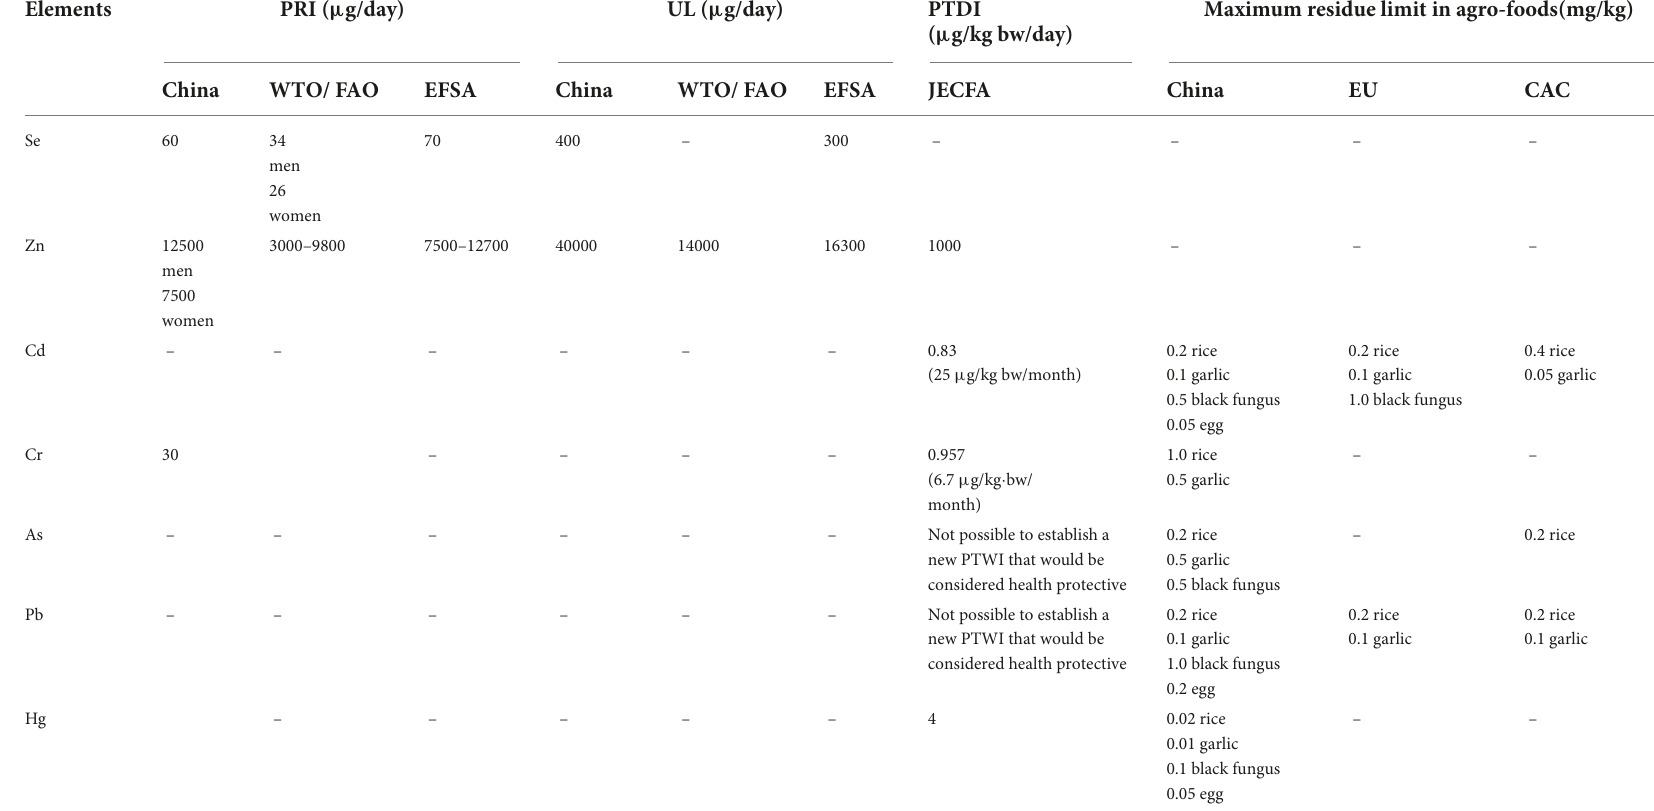
TABLE 1 PRIs and ULs of selenium and PTDIs and maximum residue limit in agro-foods of potential associated metals.